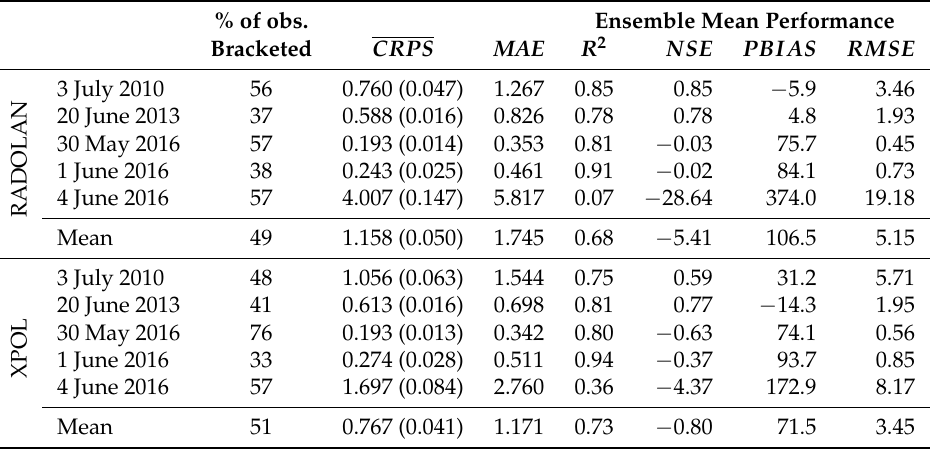
Figure 4. ParFlow hindcast discharge time series results, where P is the precipitation in mm 5min − 1 and Q is the discharge in m 3 s − 1 . Table 4. ParFlow reanalysis ensemble